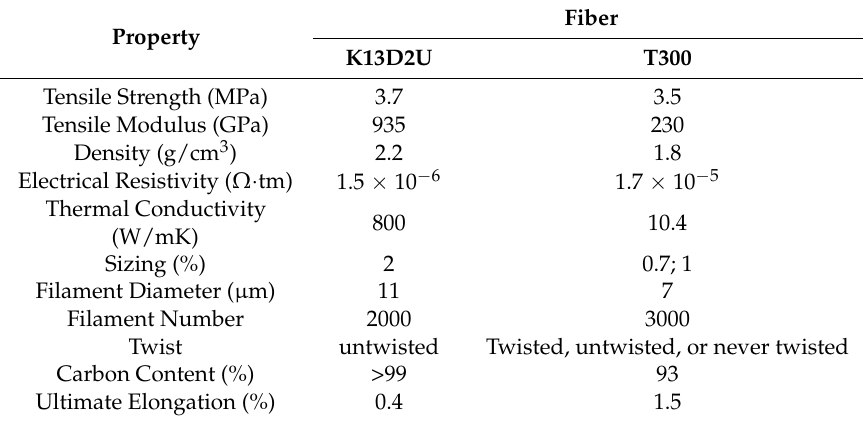
Table 3. Properties of carbon fibers